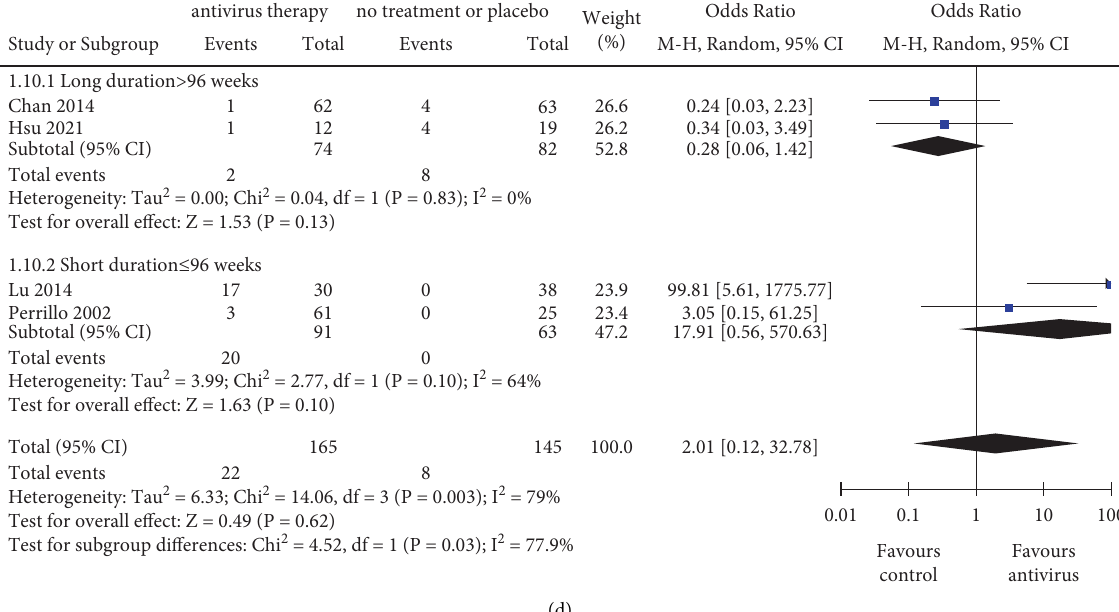
Heterogeneity: Tau 2 = 6.33; Chi 2 = 14.06, df = 3 (P = 0.003); I 2 = 79% Test for overall efect: Z = 0.49 (P = 0.62) Test for subgroup diferences: Chi 2 = 4.52, df = 1 (P = 0.03); I 2 =